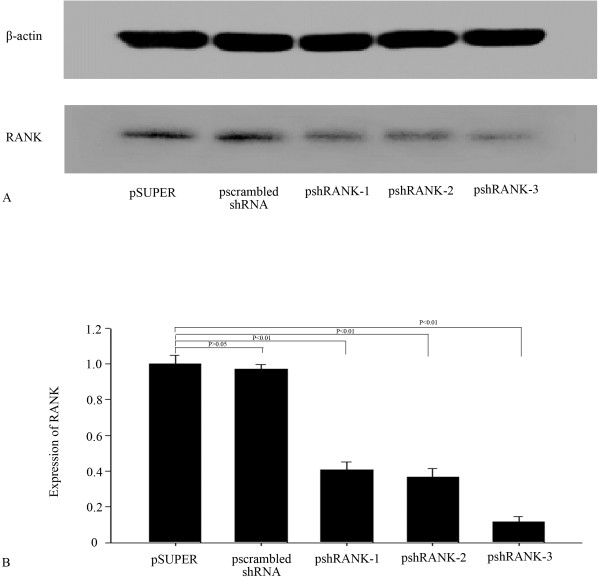
Western blot for RANK (A) and the inhibition rate of psh RANK-1, psh RANK-2 and psh RANK-3 (B) in BMMs. Figures 1 RANK gene expression inhibited by shRNAs and the inhibition rate of psh RANK-1, psh RANK-2 and psh RANK-3. Lane 1: Psuper-retro-puro; lane 2: pscrambled shRNA; lane 3: psh RANK-1; lane 4: psh RANK-2; lane 5: psh RANK-3.